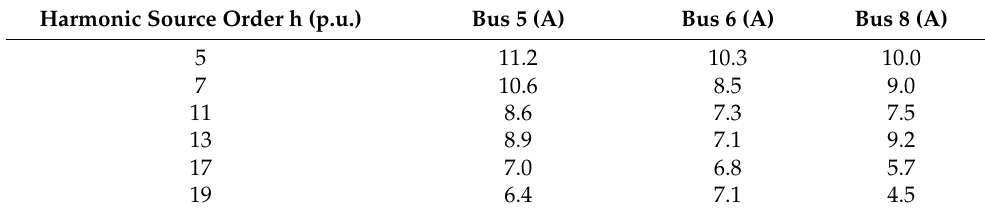
Table 2. Node harmonic current injection orders and sizes. Harmonic Source Order h (p.u.)